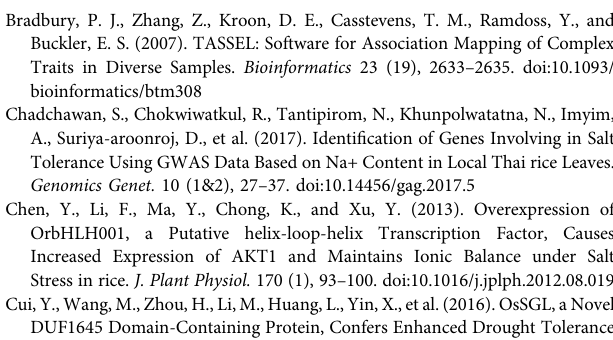
Supplementary Figure 1 | Linkage disequilibrium (LD) decay and comparison. The genome-wide LD decay comparison between Geng, Xian, and whole populations. Supplementary Figure 2 | Correlations between the measured traits; intensity of blue and red colors indicates positive and negative correlations, respectively. SupplementaryFigure3| ManhattanplotofimportantQTLandhaplotypeanalysis of candidate genes. These genes are related to corresponding QTL including analysis of candidate genes done by using SAS general linear model approach ( (A) : qBM9a, (B) : qSGr3, (C) : qAGr4, (D) : qCL9b, (E) : qAGr9). Each point was a gene in the 200-kb region of the peak SNP of QTL. Dot line showed the threshold to determine candidate genes. The suggested signi fi cance of ANOVA at p < 0.01. The letters on histogram (a and b) show multiple comparisons result at the signi fi cant level of 0.01. The value on top of histogram was the number o fi ndividuals for each haplotype, and histogram length shows the mean value of these individuals for each haplotype. SupplementaryFigure4| GeneOntology(GO)termsthatenrichsigni fi cantgenes. The color indicates the degree of enrichment from red (highly enriched and signi fi cant) to white (not enriched). Supplementary Figure 5 | Gene Ontology (GO) comparison of GO terms for biological processes is signi fi cantly associated with the traits of AGT, SGT and ASGT. The term overlap shows the four ways of constructing